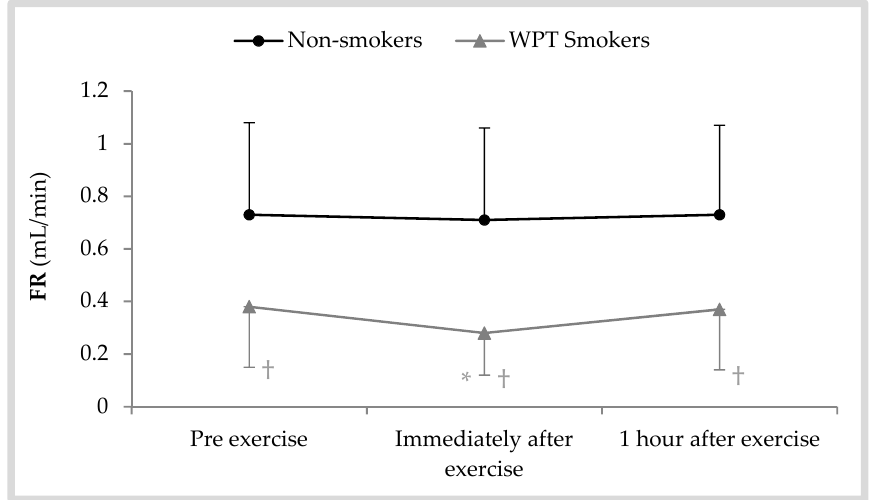
Figure 2. Saliva flow rate (FR) following a bout of exhaustive aerobic exercise for WPT smokers and non-smokers; * p < 0.05 vs. pre, † p < 0.05 vs. non-smokers.